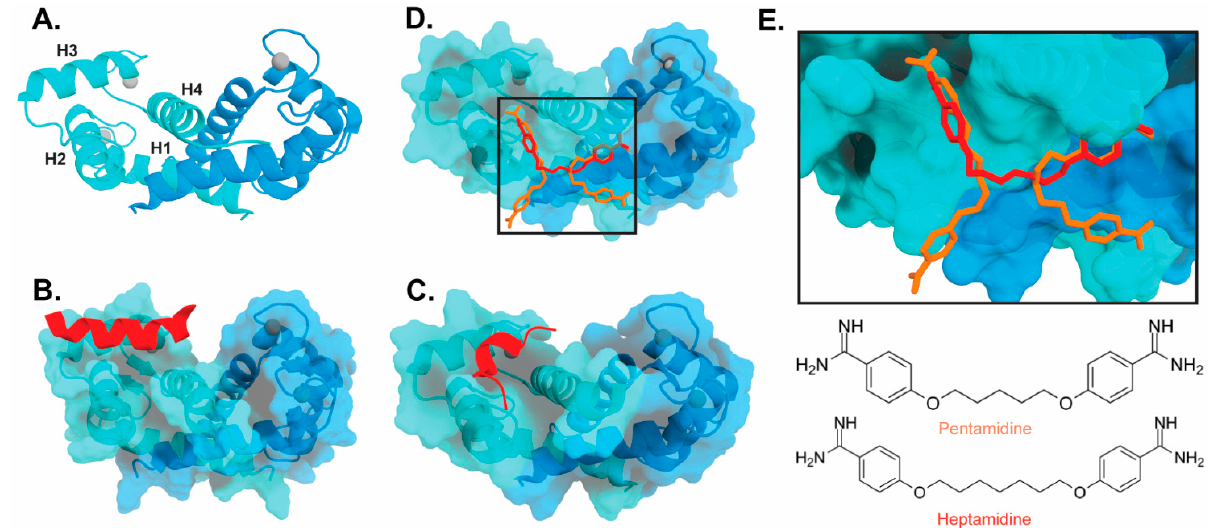
Figure 3. Binding of ligands to S100B: ( A ) Ribbon structure of calcium-bound S100B dimer (PDB 3D10) individual subunits are marked in blue and cyan with calcium represented as gray spheres. The four helices of one S100B subunit are labeled H1–H4. ( B ) S100B bound to p53-derived peptide (PDB 1DT7). ( C ) S100B bound to RAGE-derived peptide W61 (4XYN). ( D ) S100B bound to two molecules of pentamidine and one molecule of heptamidine (4FQO). ( E ) Zoomed in view of panel D binding site. Chemical structures are shown below.